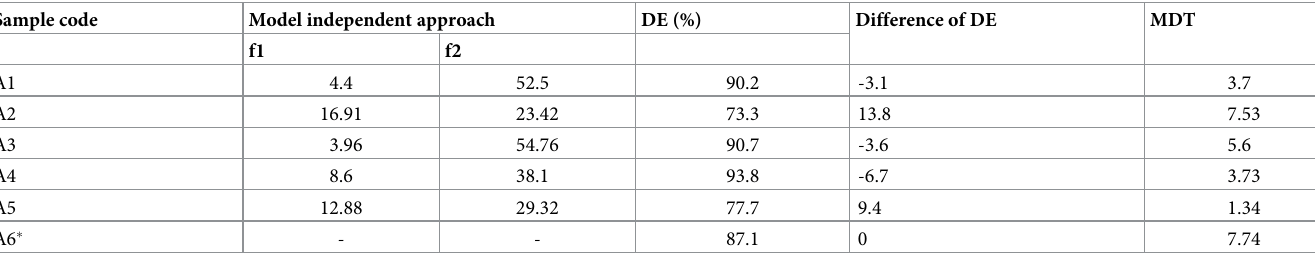
Table 12. Comparisons of dissolution profile by model independent parameters. Sample